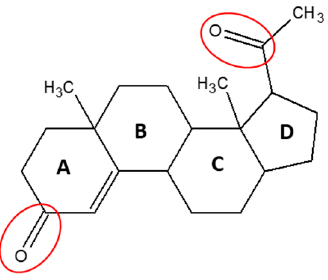
Figure 1. Chemical Structure of Progesterone. Reduction and hydroxylation of the two ketone groups (circled red) make progesterone vulnerable to liver and intestinal metabolism [24,25].